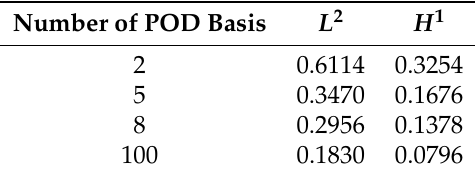
Table 2. Average POD